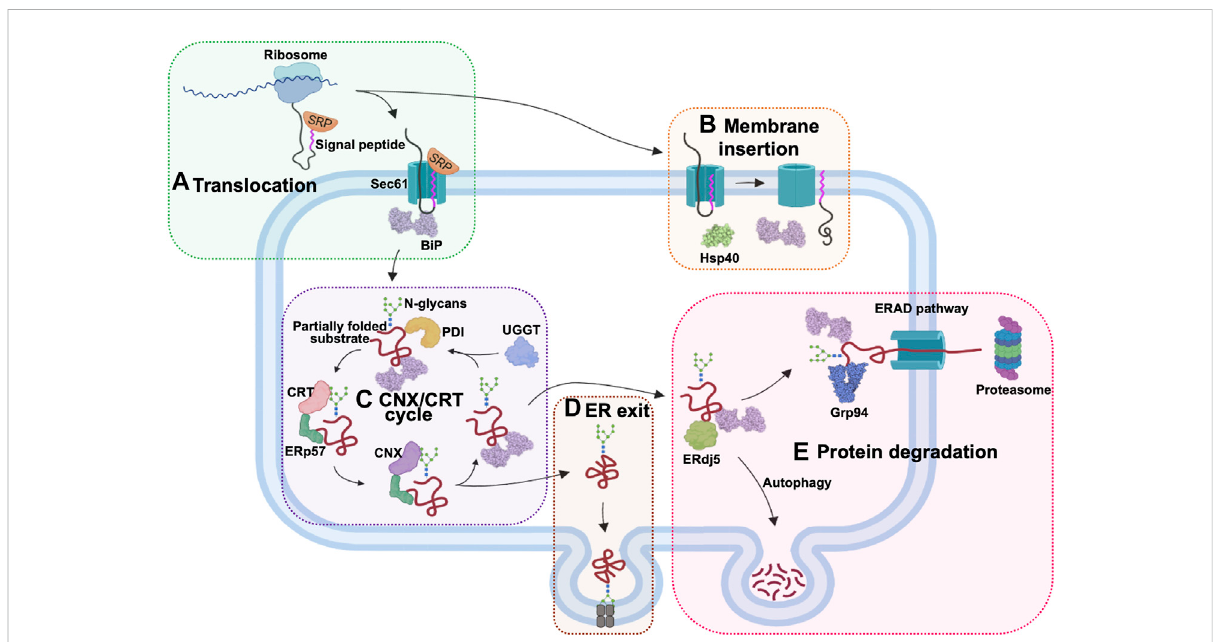
FIGURE 3 The role of ER chaperones in proteostasis. The ER-localised chaperones have numerous roles in this cellular organelle. (A) ER chaperones enablethetranslocationofproteinsintotheER.Newlysynthesizedproteinsaretargetedbythesignalrecognitionparticle(SRP)astheyemergefrom theribosomes.TheSRP-boundproteinenterstheERthroughtheSec61transloconproteinchannelandisboundbyHsp70(Grp78/BiP)insidetheER lumen for active import. (B) Chaperones also facilitate post-translational ER membrane insertion of proteins. (C) The CNX/CRT chaperone system facilitates proper glycosylation of proteins targeted for various cellular compartments. (D) ER chaperones are involved in processing the exit of the proteins via the ERGIC pathway. (E) Proteins that are not properly folded are bound by ERdj5, BiP, and Grp94 in the ER and channelled for degradation by autophagy or through the ERAD pathway in the